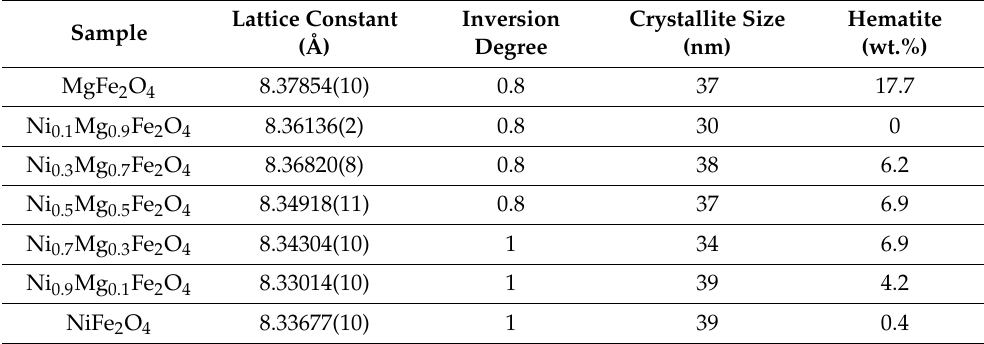
Figure 2. XRD patterns of Ni x Mg 1-x Fe 2 O 4 (0 ≤ x ≤ 1) ( a ); (311) peak shift with magnesium substitu- tion with nickel ( b ); and refined XRD diffractogram of Ni 0.3 Mg 0.7 Fe 2 O 4 ( c ). Table 1. Lattice parameters, inversion degree, crystallite size and hematite content determined for Ni x Mg 1-x Fe 2 O 4 (0 ≤ x ≤